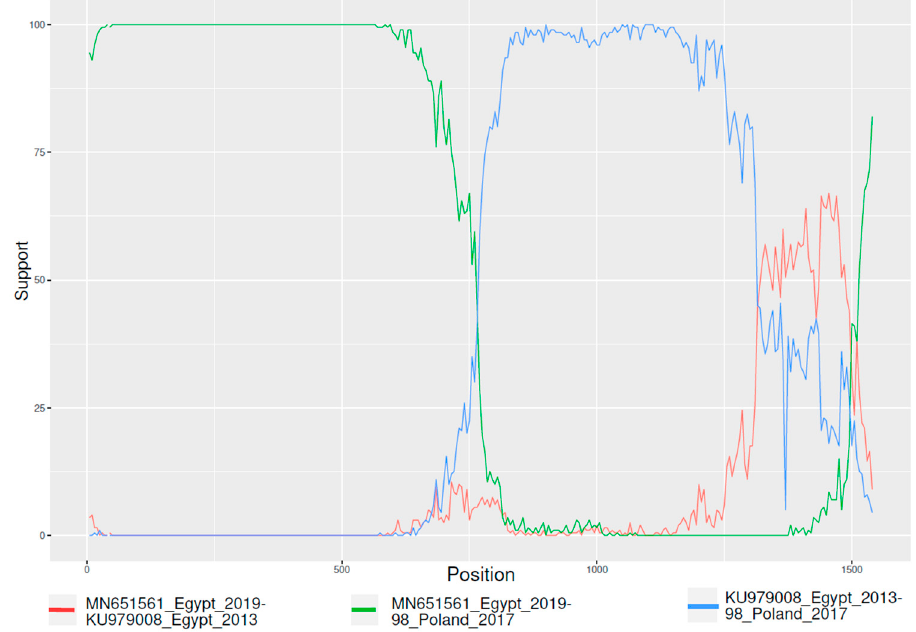
Figure 1. Result of bootscan analysis performed with RDP4. For reasons of clarity, only one sequence representative of recombinant, major, and minor parents are reported. Y and x-axis depict the bootstrap support and the nucleotide position of the S1 gene.